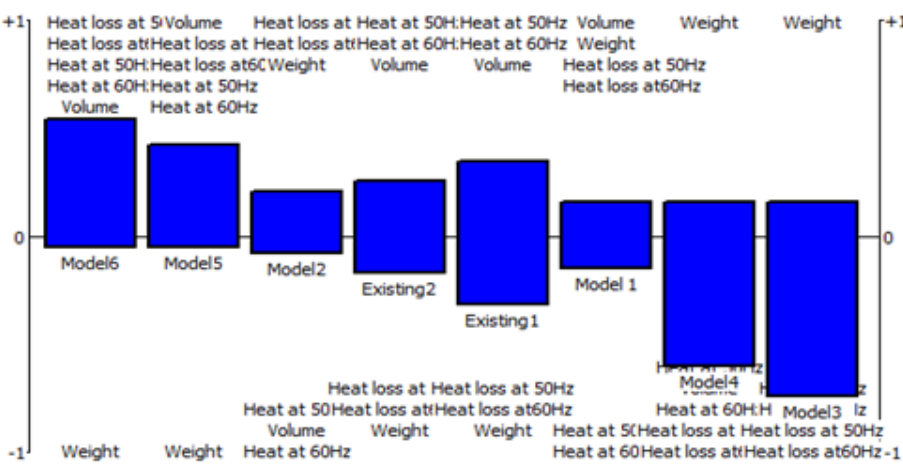
Figure 19. Criteria panel for all models.